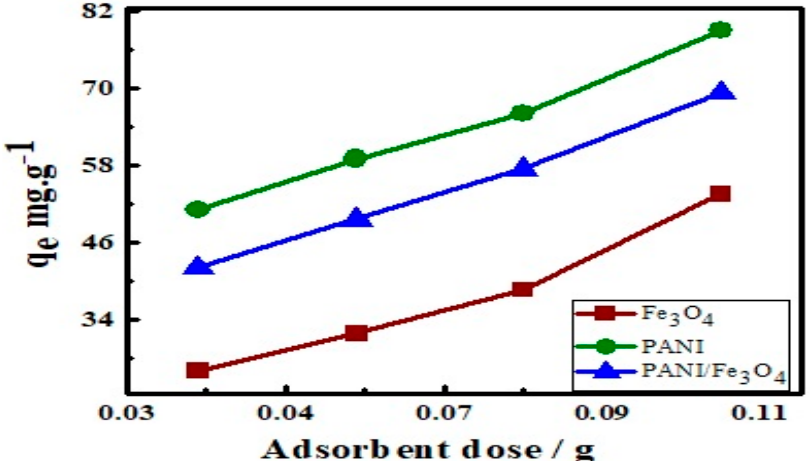
Figure 9. The effect of ionic strength of ( a ) Na 2 SO 4 .7H 2 O and ( b ) CaCl 2 .2H 2 O on adsorption of AB40 onto Fe 3 O 4 , PANI and PANI/Fe 3 O 4 composite.